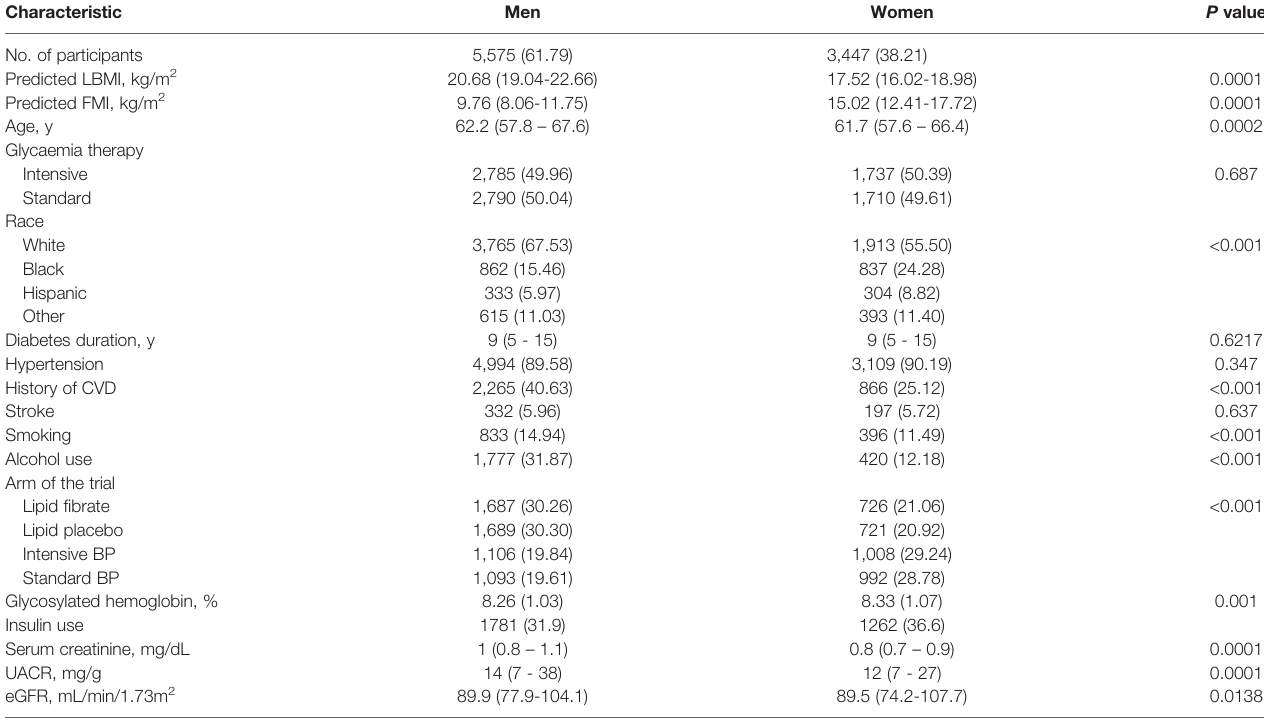
TABLE 1 | Baseline characteristics of included participants by sex.